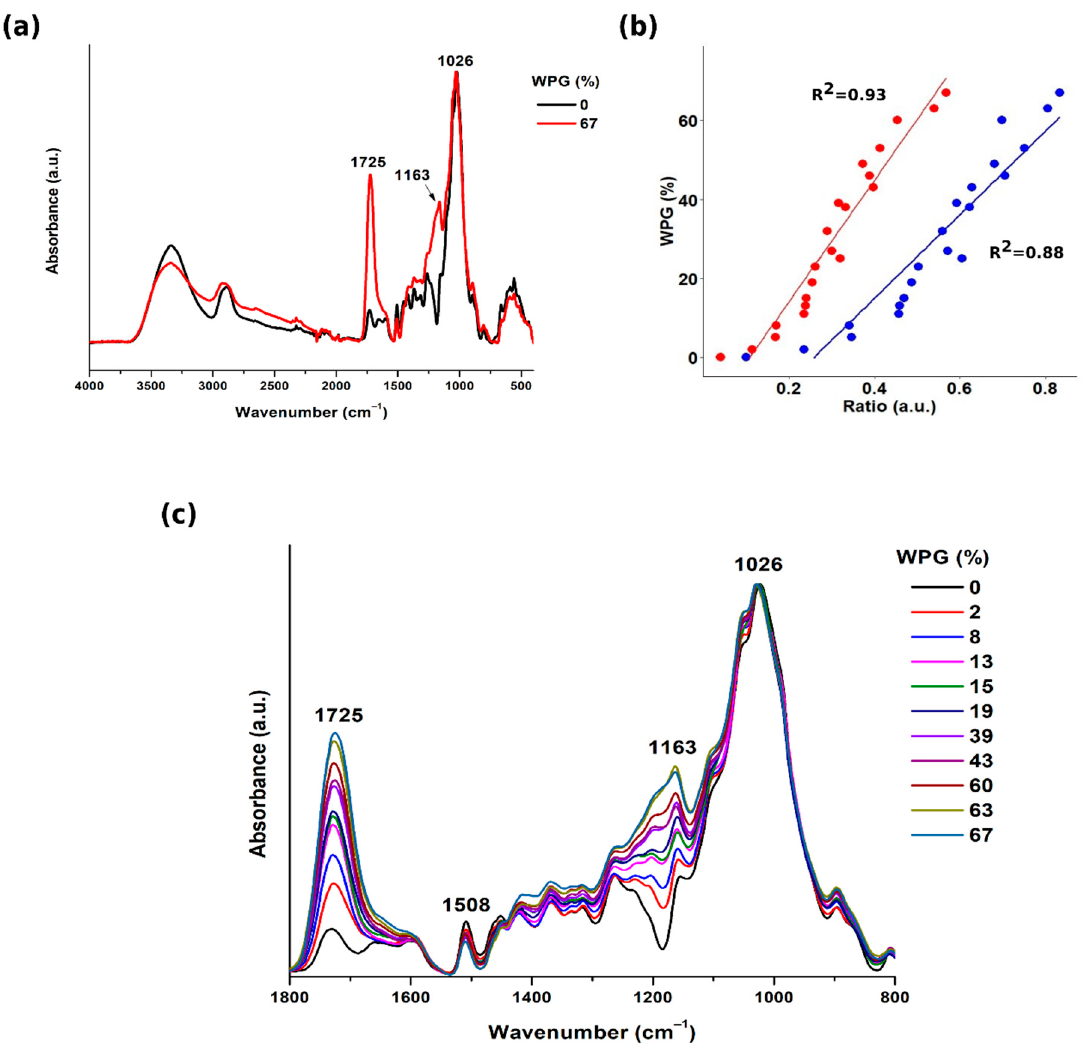
Figure 3. ATR-FTIR spectra of ( a ) untreated (black curve) and SorCA-treated (red curve) wood; ( b ) correlation between the WPG and the band area ratio (BAR, red line) and band height ratio (BHR, blue line) in the wavenumber range 1774–1689 cm –1 /1139–914 cm –1 , calculated from ATR-FTIR spectra of SorCA-treated wood; ( c ) overlay of the selected ATR-FTIR spectra of SorCA-treated wood with increasing WPG.